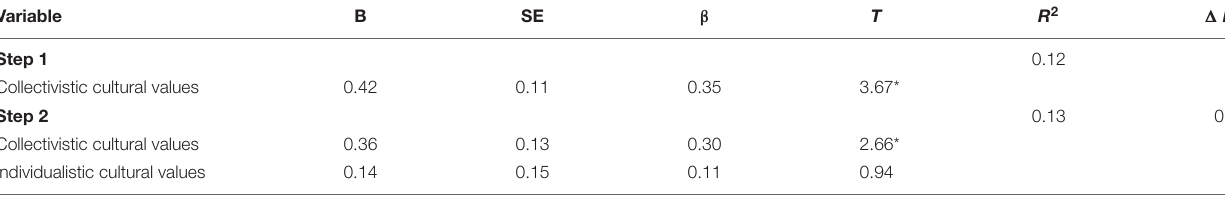
TABLE 6 | Hierarchical regression of Mainland Chinese mothers’ parental goals.